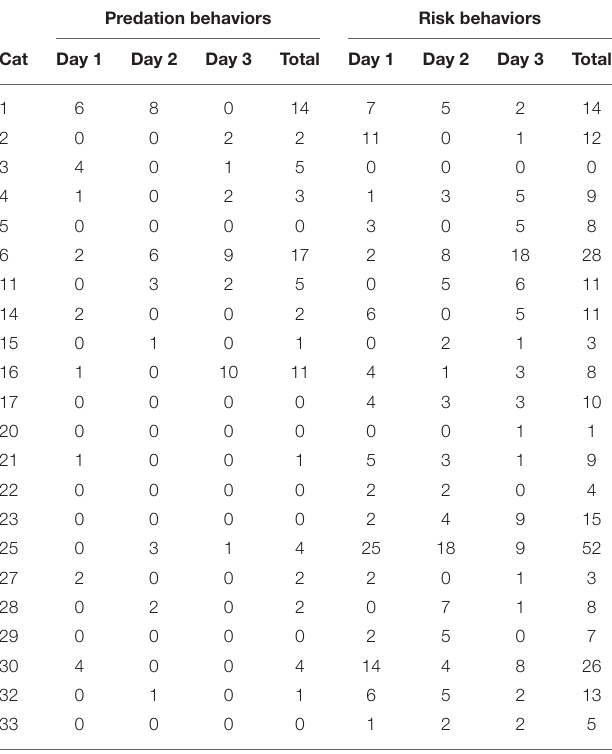
TABLE 7 | Count of predation behaviors and risk behaviors per day for the 22 owned free-roaming cats with three full observation days. Predation behaviors Risk